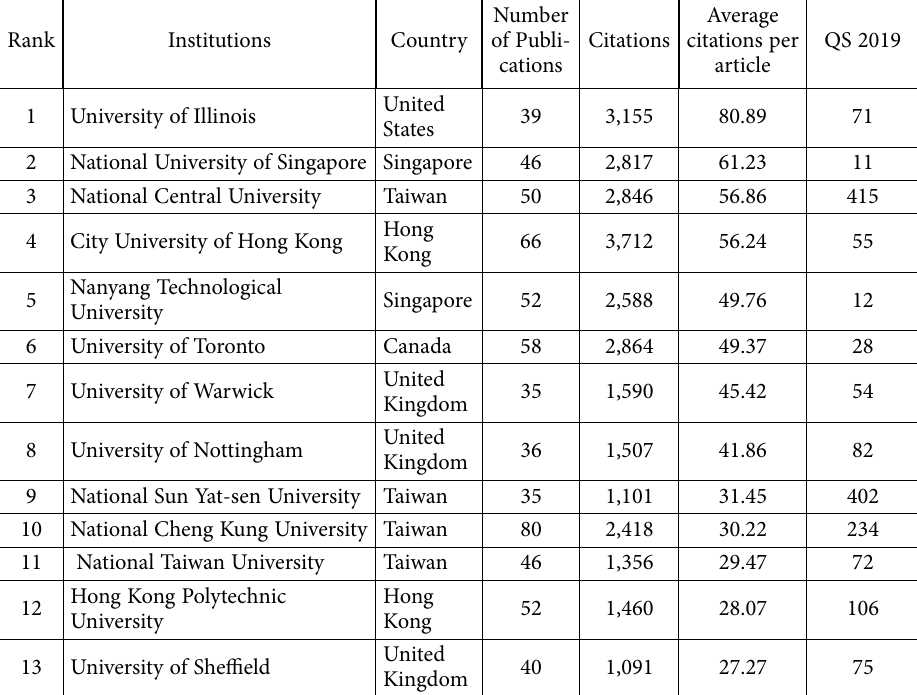
Table 4. Top 25 contributing institutions as per average citations per article